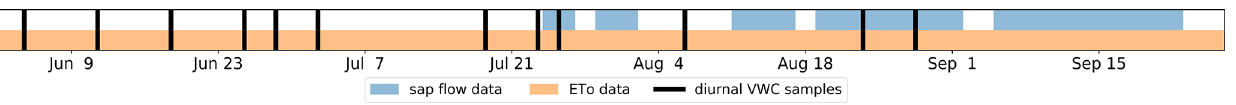
Figure 1. Availability of the data required to evaluate the adjusted methodology for estimating 15min VWC variations. The availability of the sap flow, ET 0 , and sampling data matched on 25 July and 23 and 28